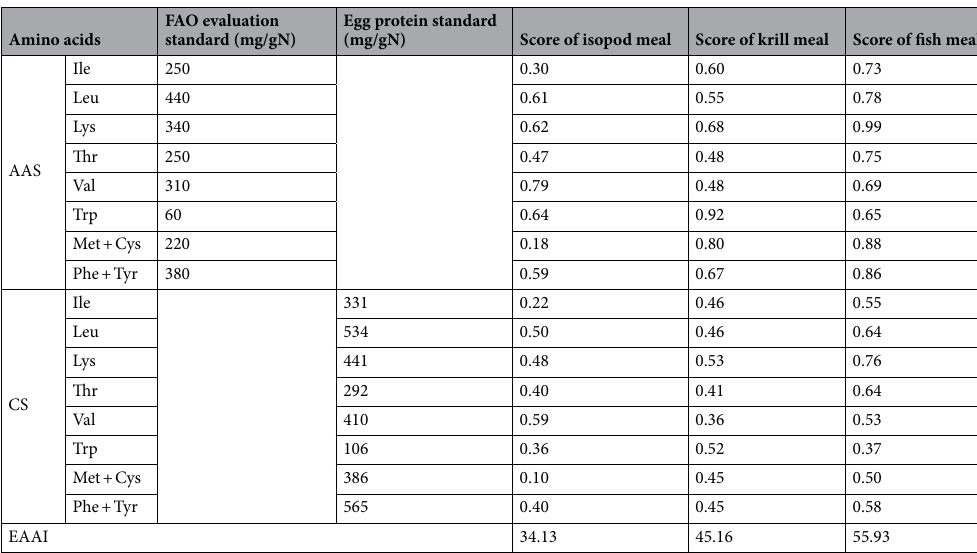
Table 3. Comparative analysis of amino acid score (AAS), chemical score (CS) and essential amino acid index (EAAI) of antarctic krill meal and isopod